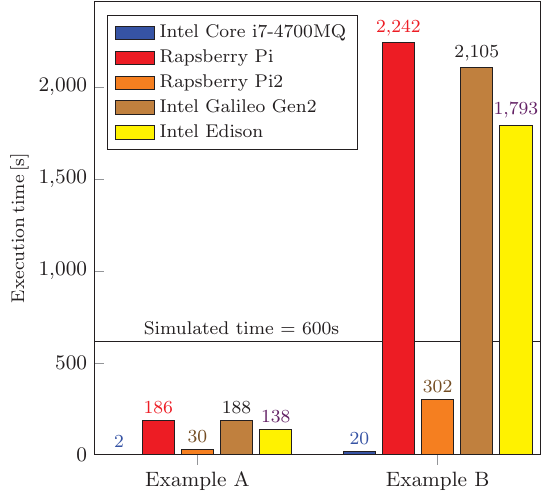
Figure 5: Performance comparison. Figure 11. Performance